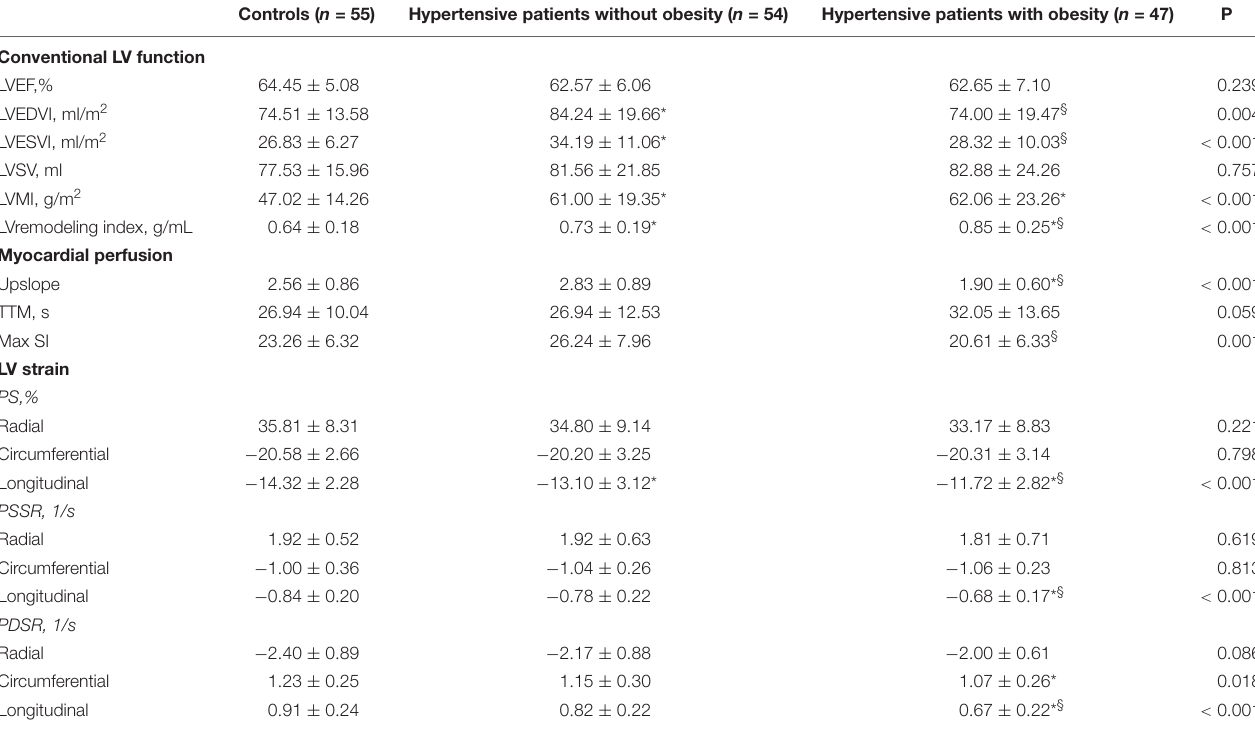
TABLE 2 | Comparisons of CMR findings between controls, non-obese and obese patients. Controls ( n = 55) Hypertensive patients without obesity ( n = 54) Hypertensive patients with obesity ( n = 47) P